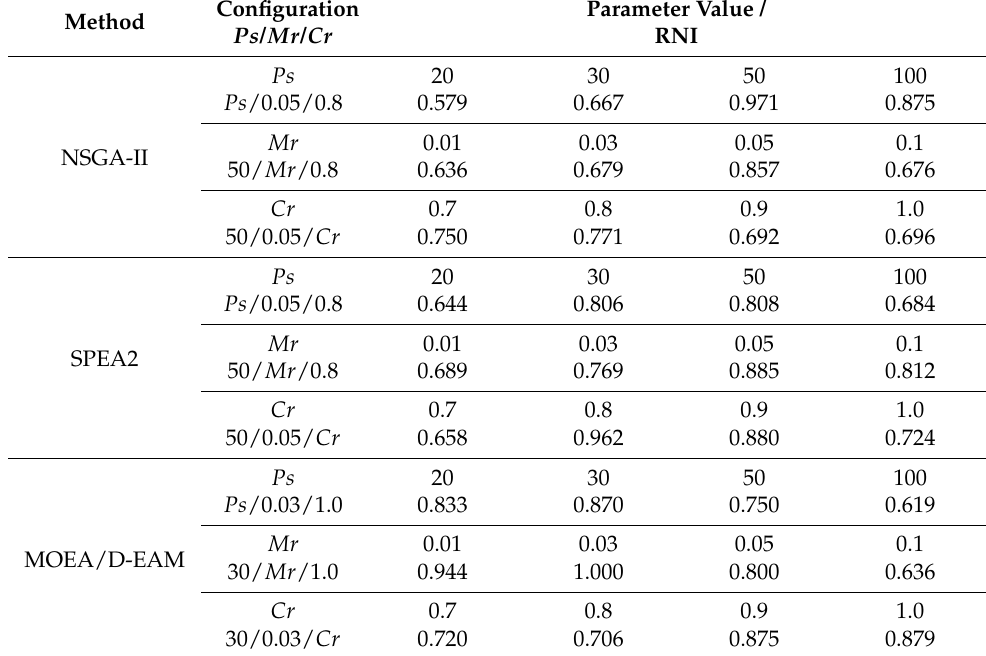
Table 2. Analysis of meta-parameter effects on quality of non-dominated solution sets, measured by the RNI metric [32]. For each optimization method, the parameters Ps , Mr and Cr were individually modified. The RNI for a configuration with specific value of the observed parameter is computed with respect to other configurations using different values of the same